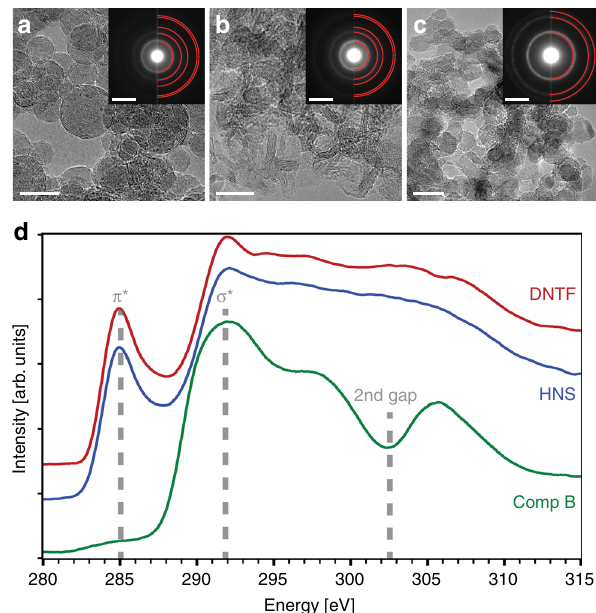
Fig. 4 TEM analysis of nanocarbon products. a – c Transmission electron micrographs and diffraction data (insets) from recovered detonation products of a DNTF, b HNS, and c Comp B, with diffraction spacings for relevant carbon phases highlighted by red semi-circles. DNTF and HNS products largely consist of graphitic structures with onion-like and fi ber-like morphologies, respectively, while Comp B contains a signi fi cant amount of diamond. Differences in the carbon allotropes for the three recovered products are also clear in carbon K-edge electron energy loss spectra d . Scale bars are 10 nm a – c and 5 nm − 1 (insets). Source data are